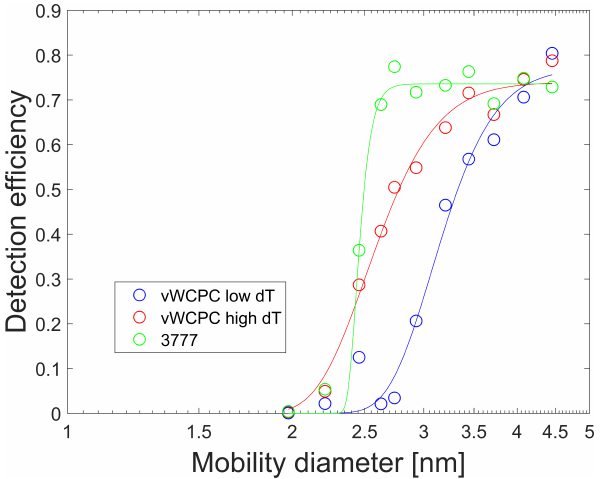
Figure 9. Detection efficiency of the CPCs as a function of size for positively charged TDDABr particles at low and high dT settings for vWCPC and at low dT settings for the 3777.